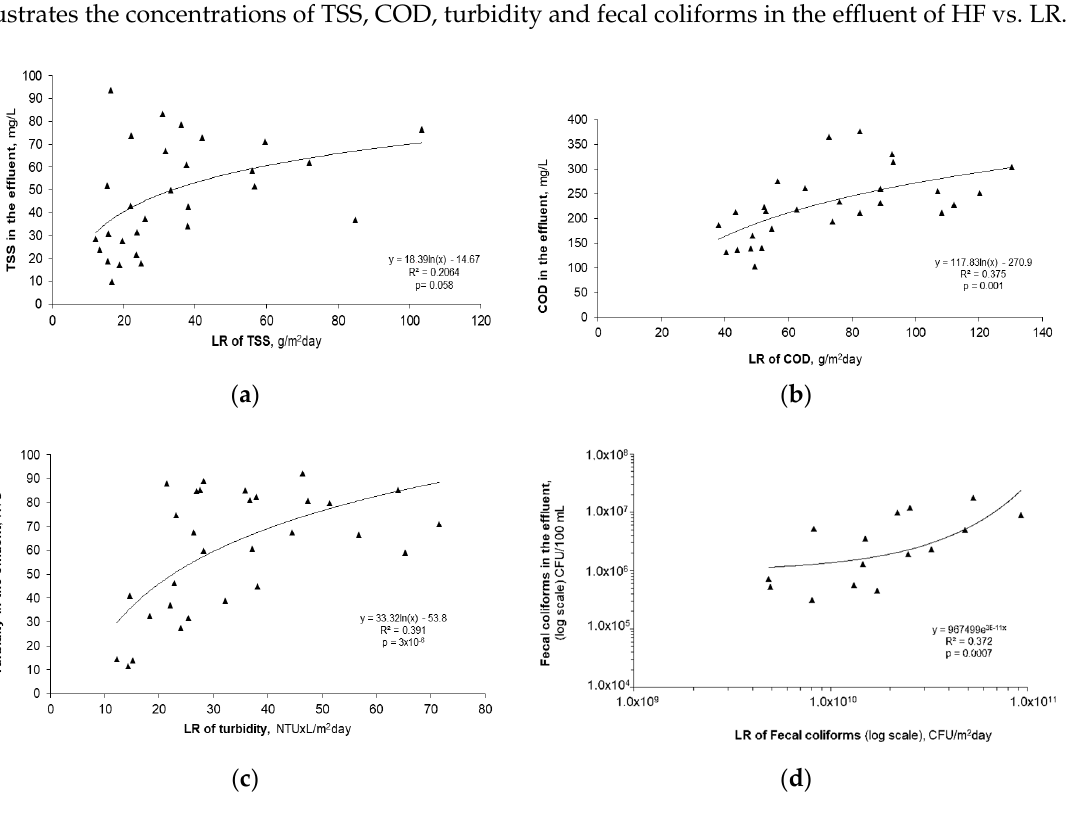
Figure 2. Concentration of ( a ) TSS, ( b ) COD, ( c ) turbidity and ( d ) fecal coliforms in the effluent of HF vs. LR. Values of R 2 and Spearman correlation coefficient are provided.